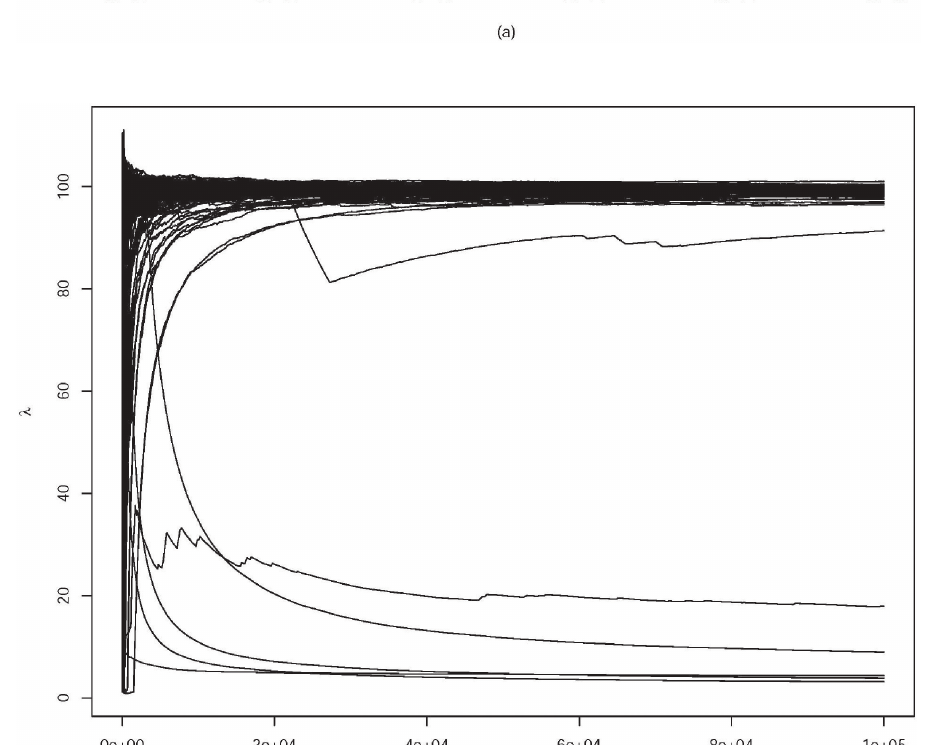
Fig 9. Cumulative mean plots of MCMC posterior samplesfor model parameters in fitting the Twitter ego- network. (a) Covariate regression coefficients ^ b